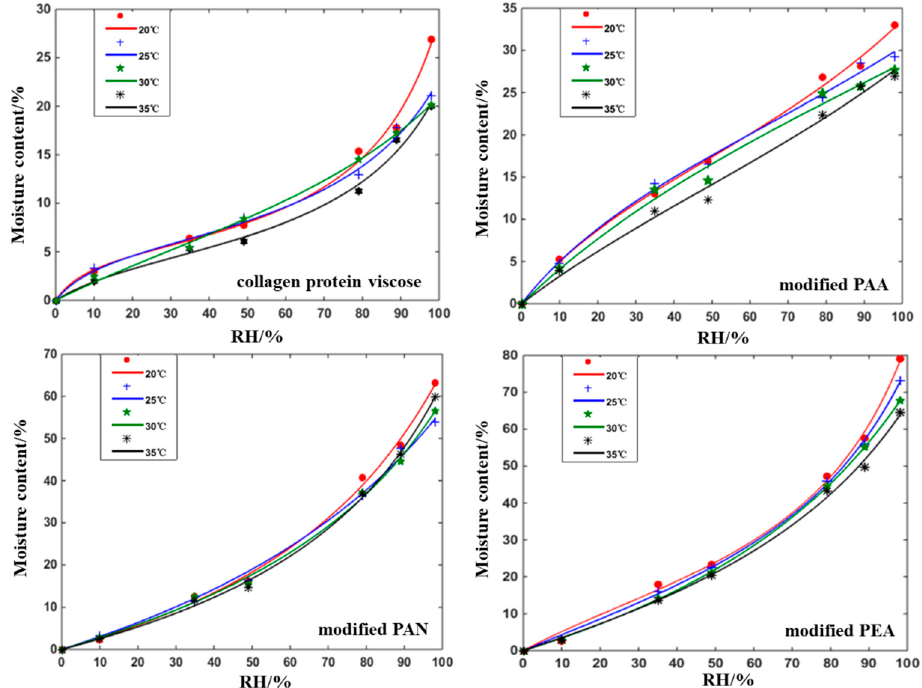
Figure 4. Experimental data and Guggenheim-Anderson-de Boer (GAB)-predicted GAB-predicted water vapor adsorption isotherms at different temperature for different fiber samples (symbols are experimental data and solid lines are the model predictions).